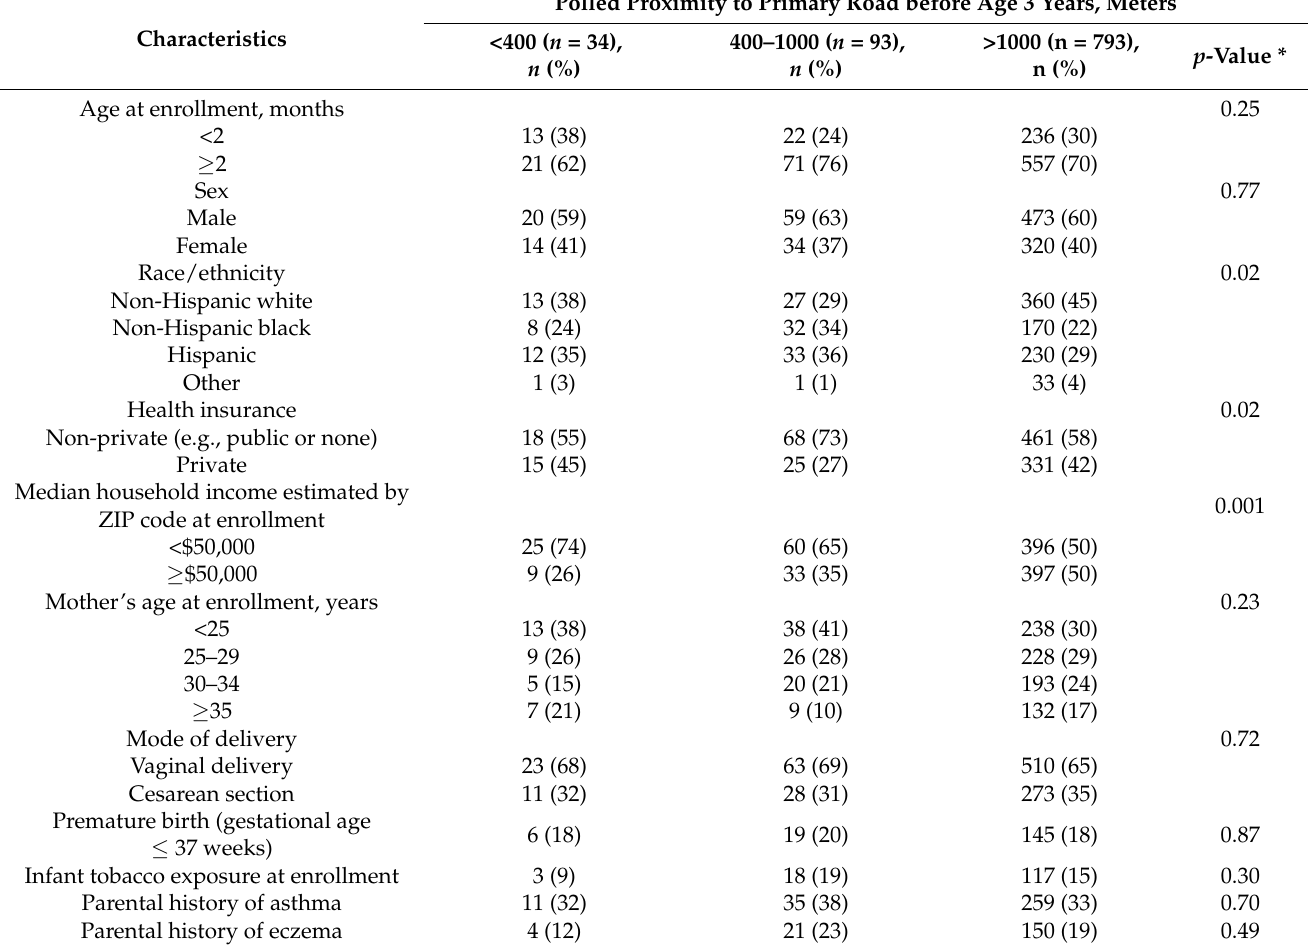
Table 2. Participant characteristics by categories of pooled proximity to primary roads before age 3 years.